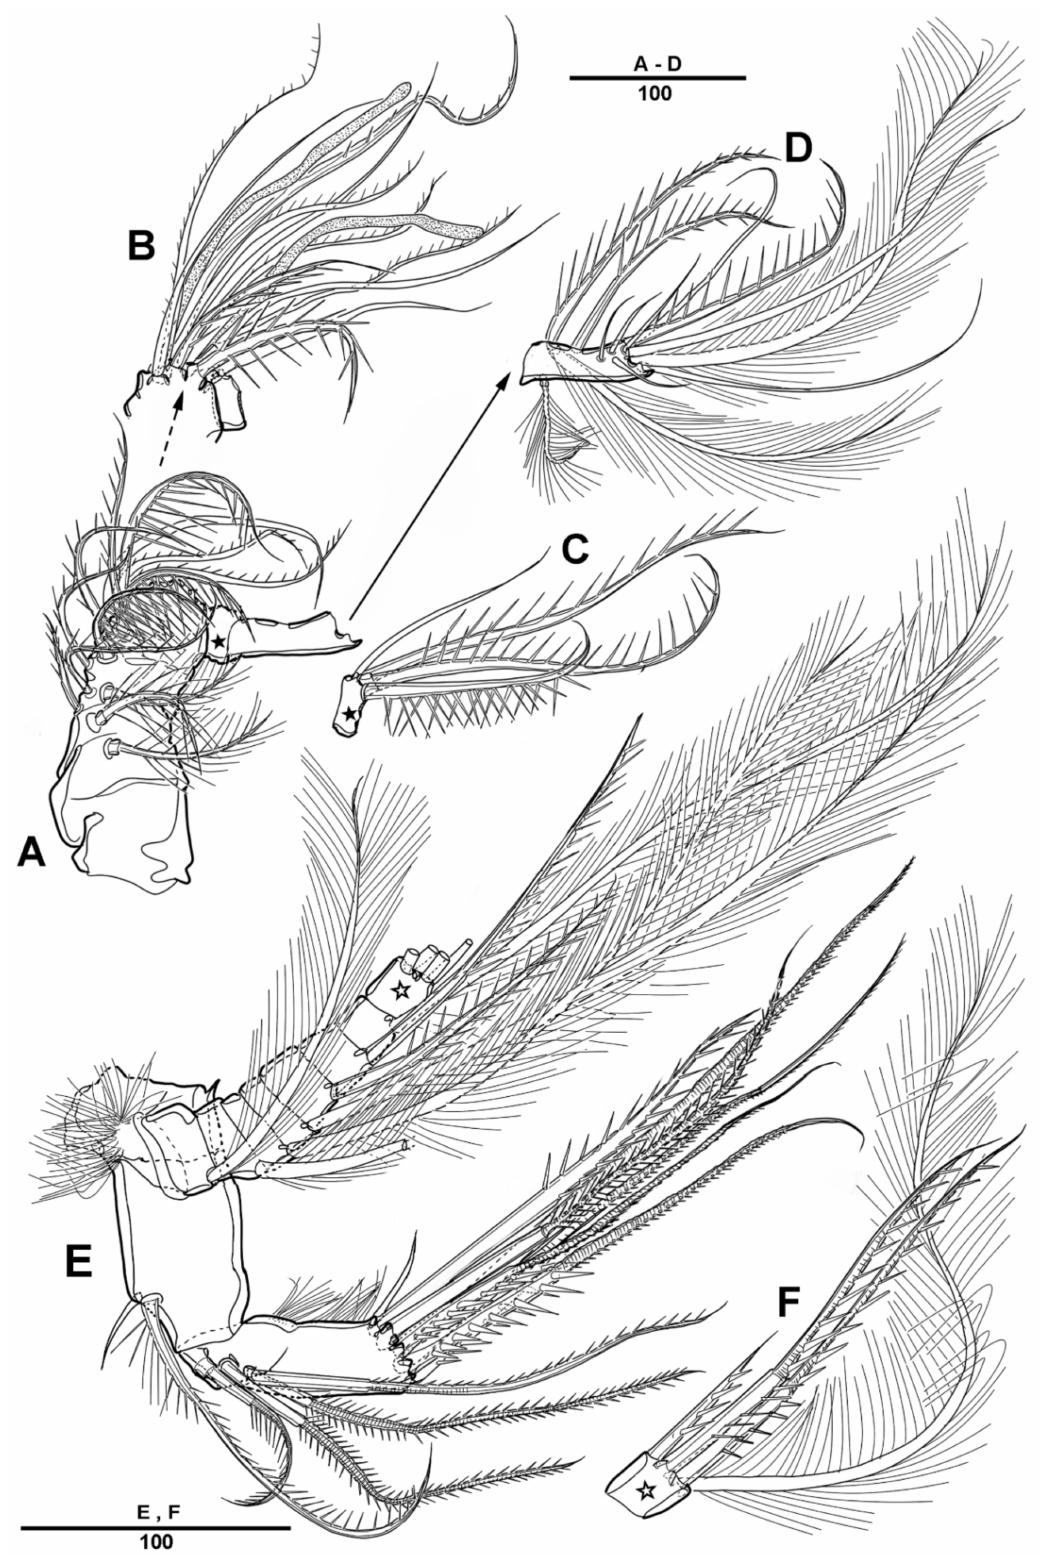
Figure 14. Scottolana wonchoeli sp. nov. holotype female: ( A ) antennule; ( B ) distal part of first antennulary segment; ( C ) antennulary segment 2; ( D ) antennulary segment 3; ( E ) antenna; ( F ) distal antennary exopod. Scale bars in µ